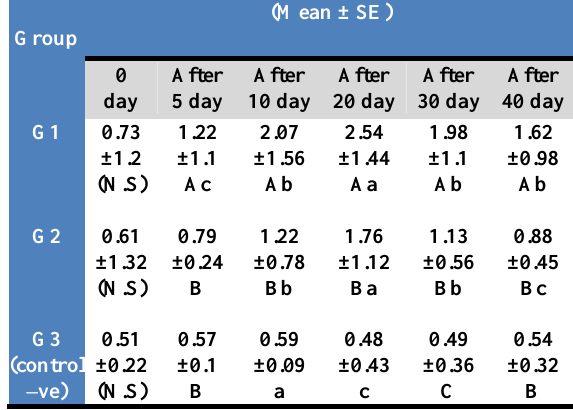
Table, 2: The differences in theIFN-γ concentrations means in immunized and non-immunized groups that were measured by ELISA method, (Mean ± SE). Group